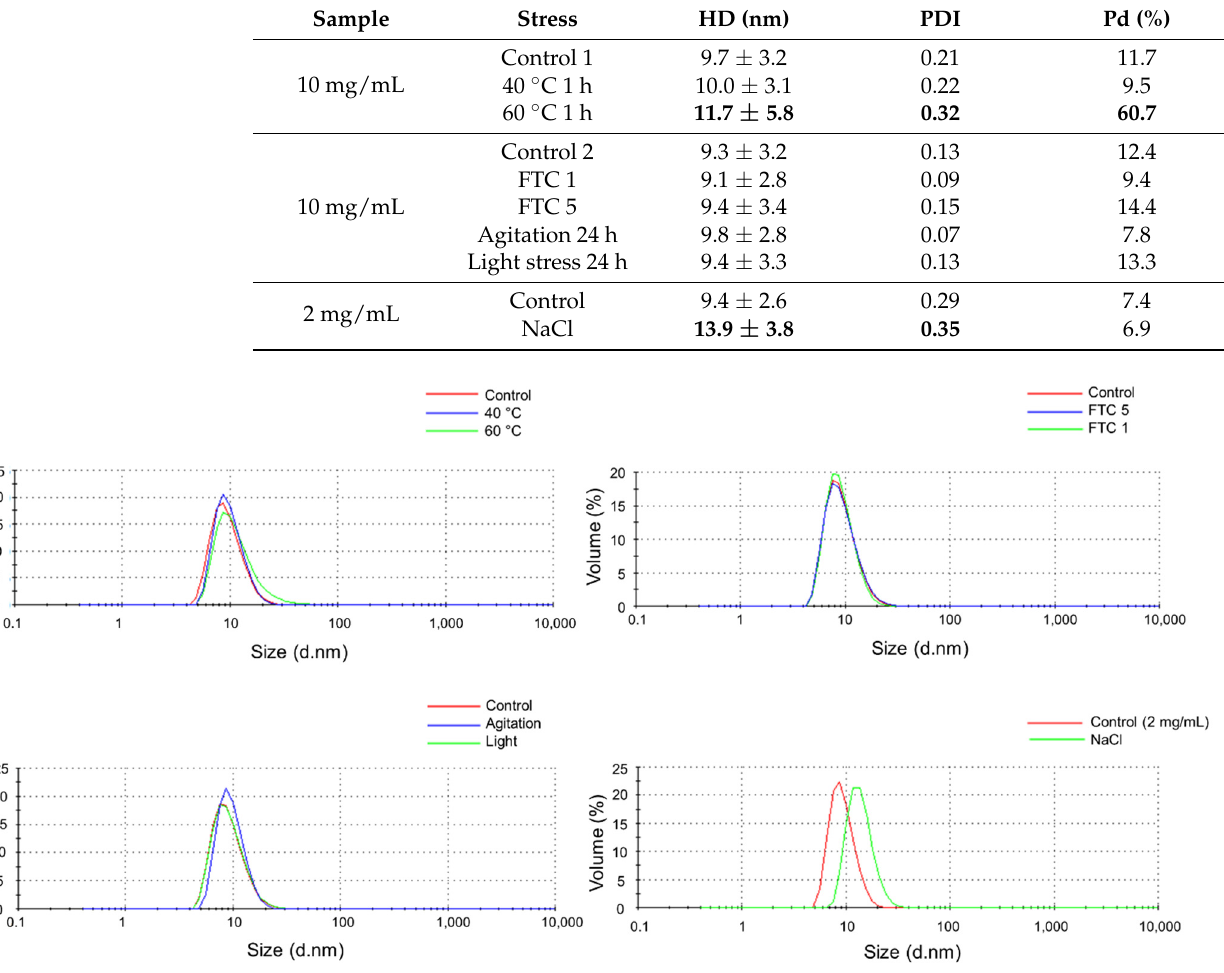
Table 4. Average hydrodynamic diameter (HD), polydispersity index (PDI) and polydispersity (%, Pd) of nivolumab sample solutions. Results that are different from the control appear in bold . Sample